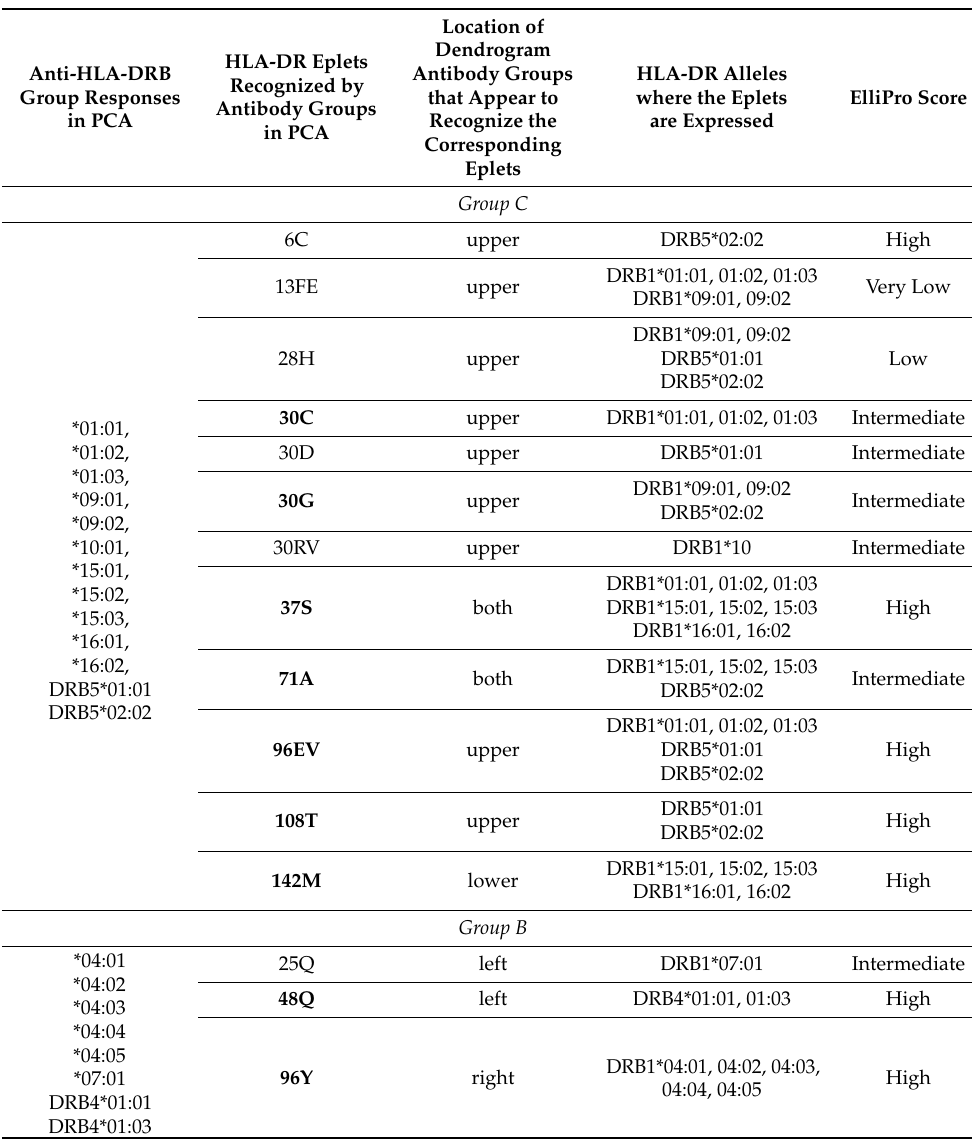
Table 1. Epitopes found exclusively in each of the groups resulted from PCA and phylogenetic analysis of anti-HLA-DR allele responses. The three distinct antibody groups as observed in PCA analysis are presented in the first column. Eplets within each group are listed in the second column. Eplets in bold are those present in more than one allele in each group and have an intermediate or high Ellipro Score. The third column shows the location of dendrogram antibody groups that appear to recognize the corresponding eplets. This dendrogram clustering confirms most of the immunogenic eplets under discussion. Eplets with very low or low ElliPro scores are considered less likely to drive the respective immune